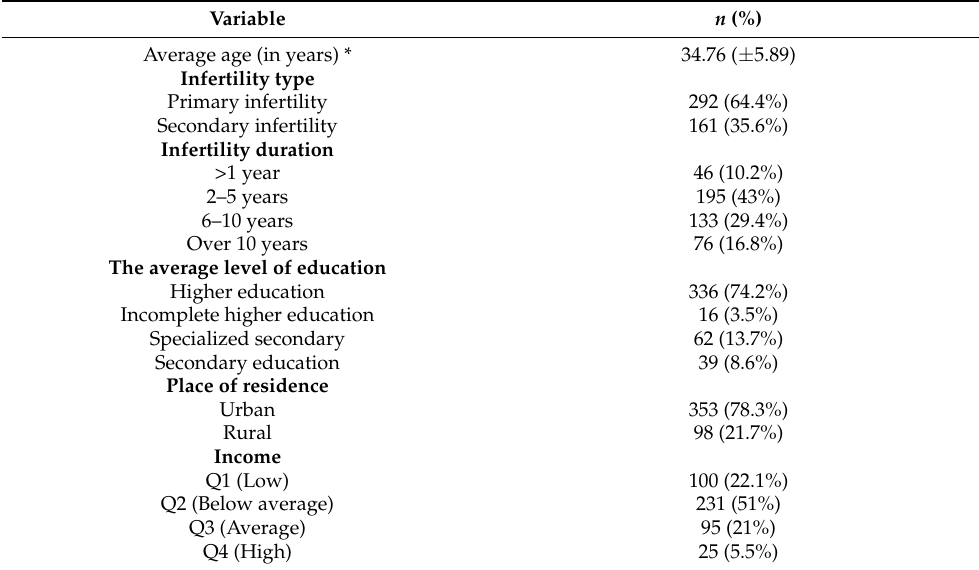
Table 1. Socio-demographic and clinical characteristics of participants.